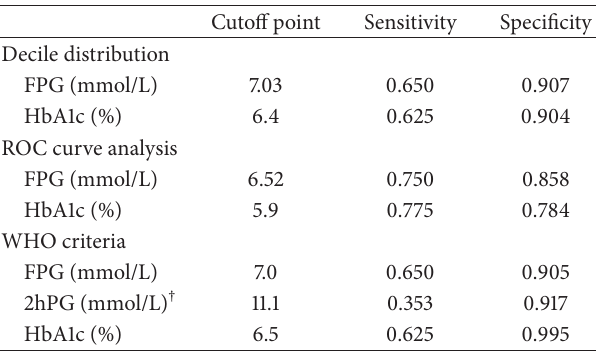
Table 2: Performances of glycemic cutoff points derived from different analytic methods and the WHO criteria in detecting